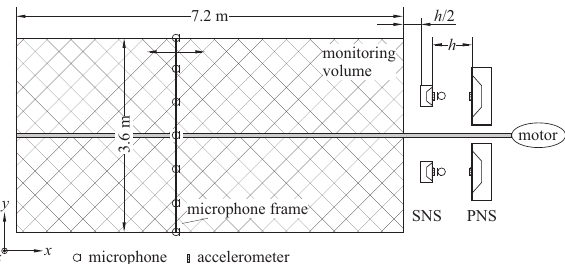
Figure 12: Measuring setup for sound pressure mapping (not drawn to scale).